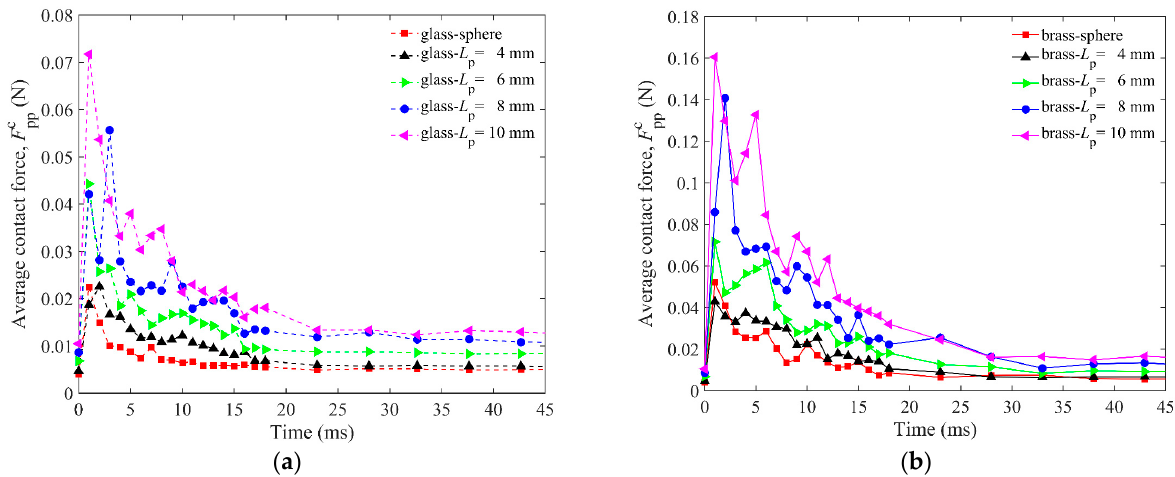
Figure 8. Average contact force of particles F c pp as a function of time for 2 mm sphere and L p = 4 mm, 6 mm, 8 mm, 10 mm elongated particles for DEM simulations: ( a ) is for the glass impactor, and ( b ) is for the brass impactor.